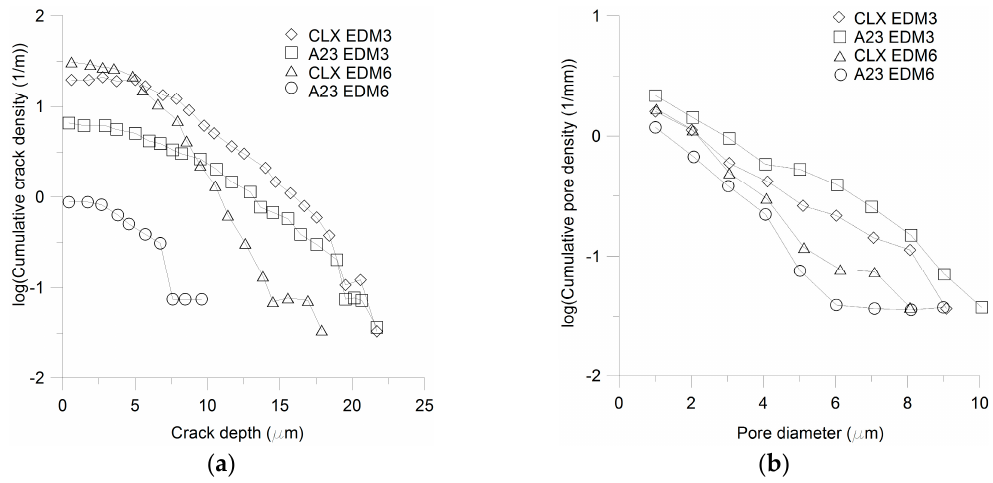
Figure 13. Defect distribution under different conditions for CALMAX(CLX) and ASP2023(A23), ( a ) cracks, after ref. [25] ( b ) pores after ref. [25].